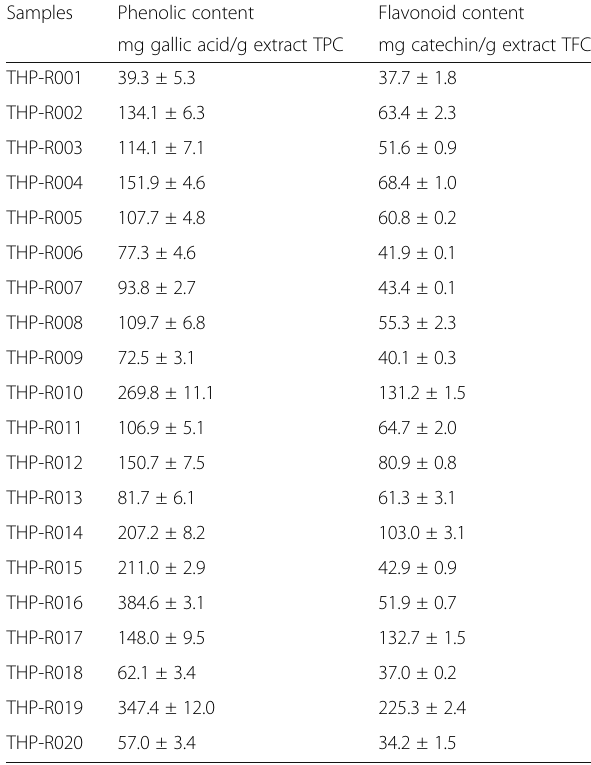
Table 2 Total phenolic and total flavonoid contents of traditional polyherbal